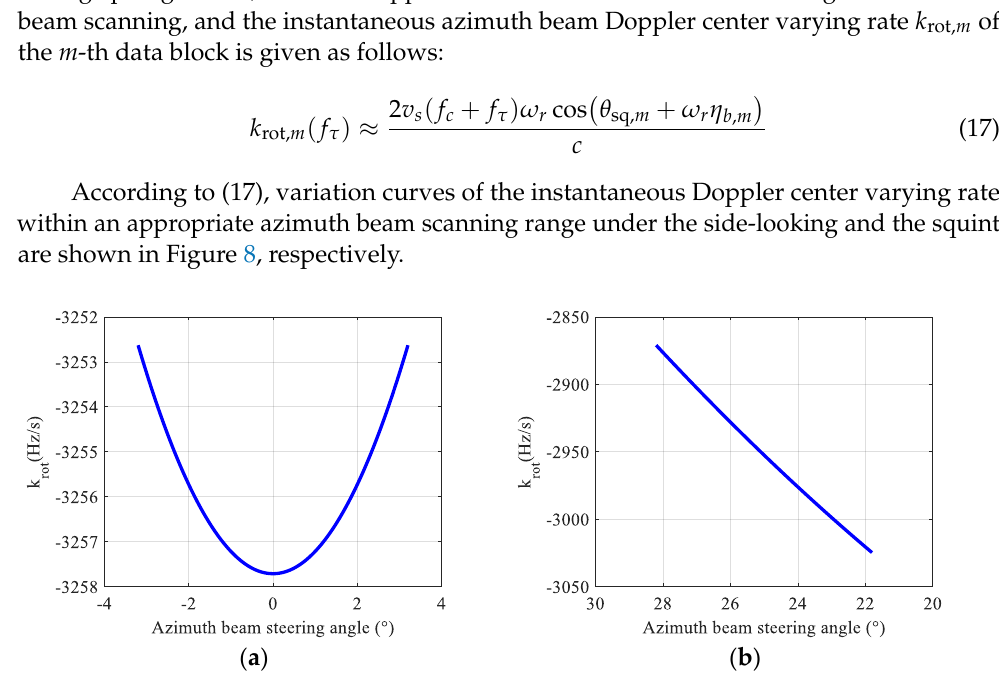
k under the side- rot k within 3.2  under rot